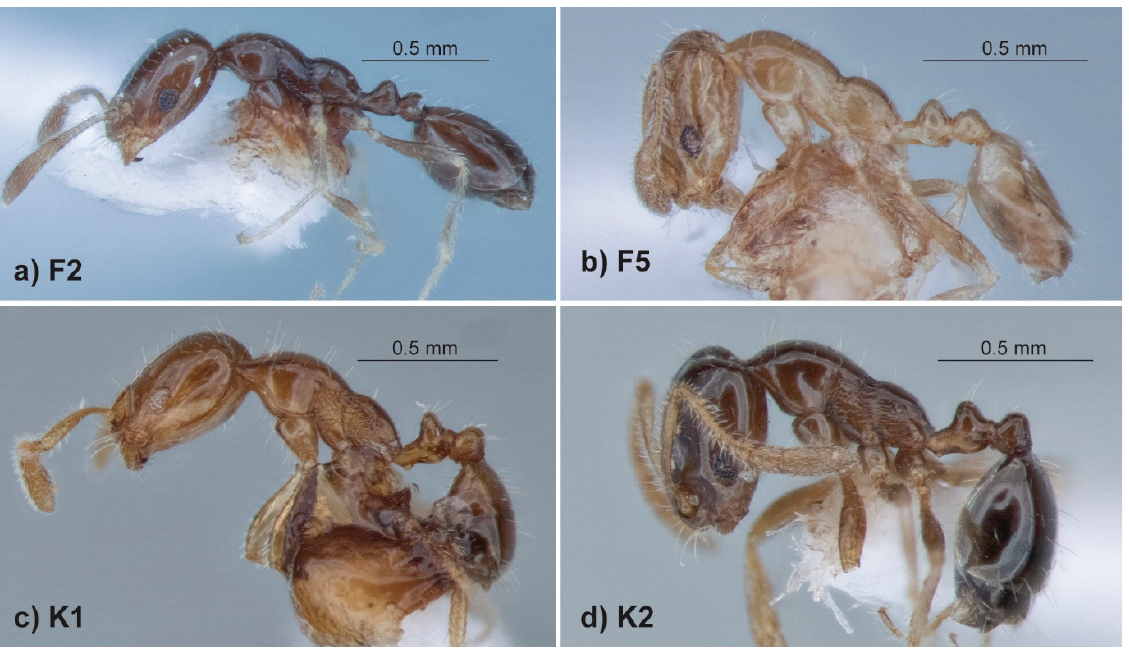
Figure 9. Images of species from the ‘sp. 9’ morphotype. ( a ) Specimen DARW250-15; Maryfield Stn, NT; ( b ) specimen MONM591-18; Mt Elizabeth, Kimberley, WA; ( c ) specimen MONS008-18; Nitmiluk NP, NT; ( d ) specimen OZBOL4039-21; Hayfield Shenandoah Stn, NT.